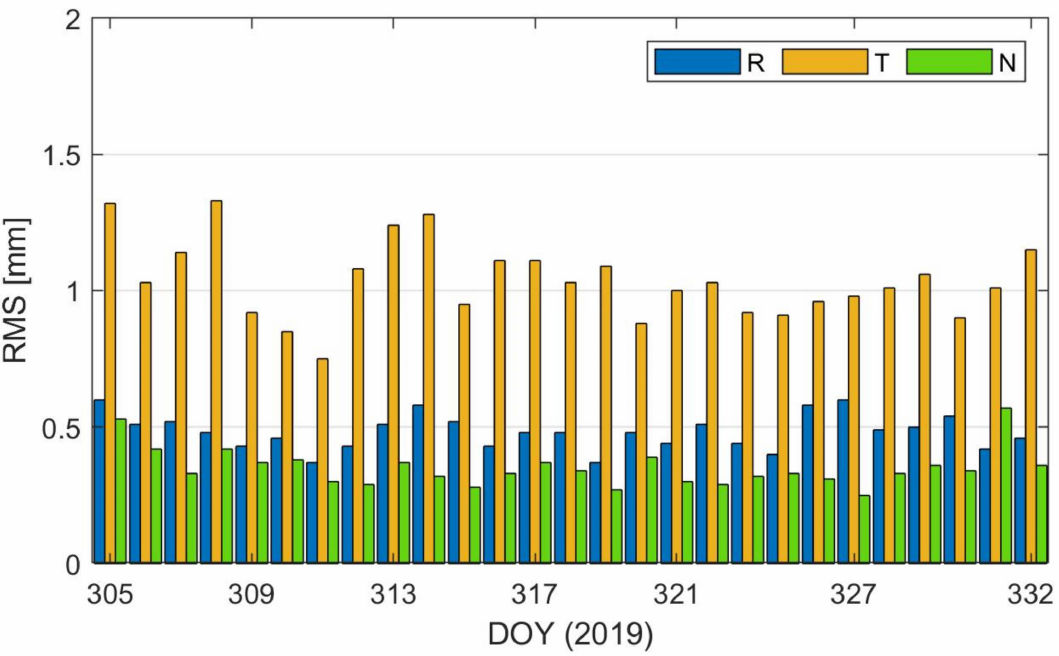
Figure 13. Difference between the GPS-based and combined PROD